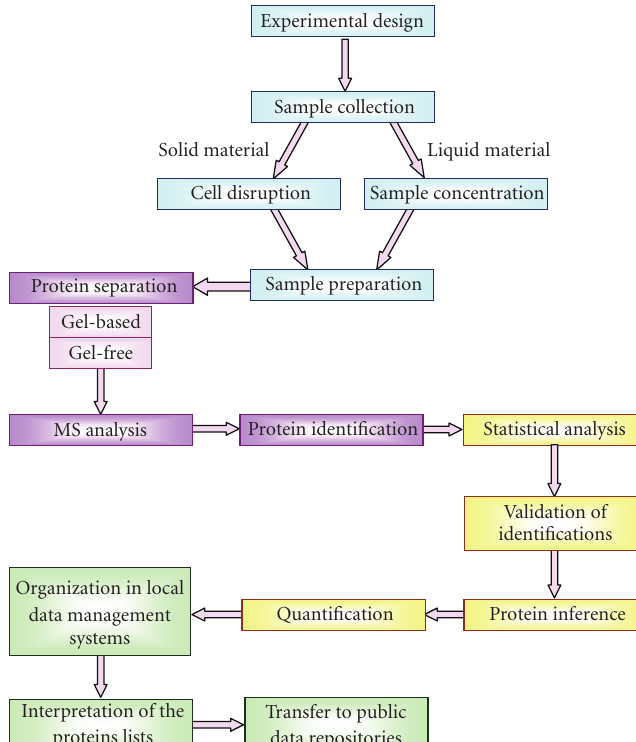
Figure 2: Schematic overview of the work flow in a fungal proteomatic approach (adapted from Deutsch et al., 2008